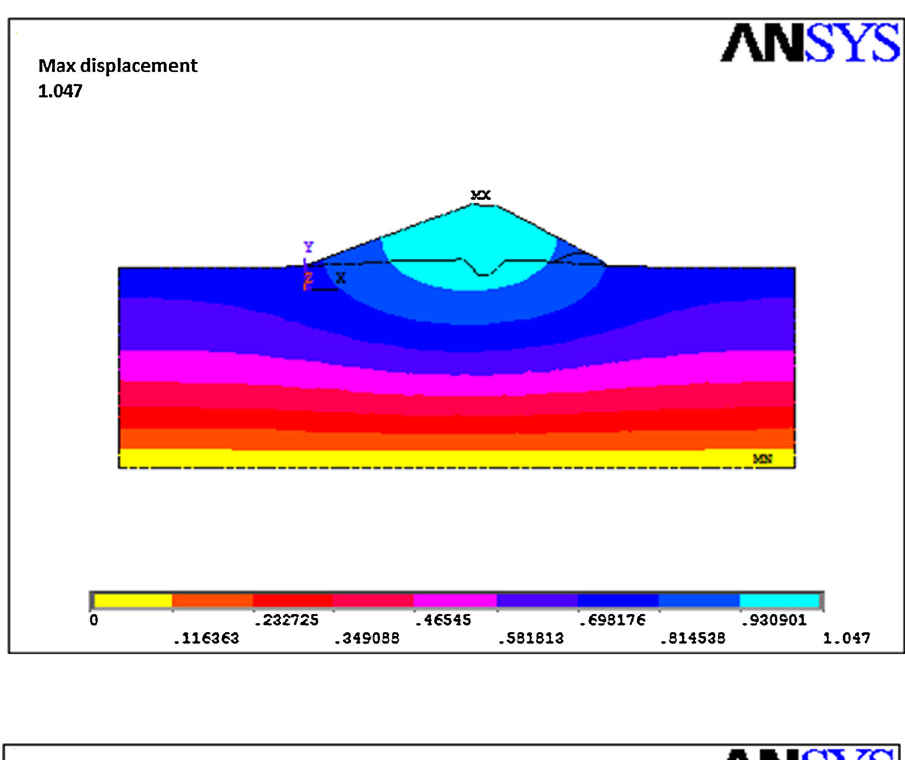
Earth dam with E Fundations = 30